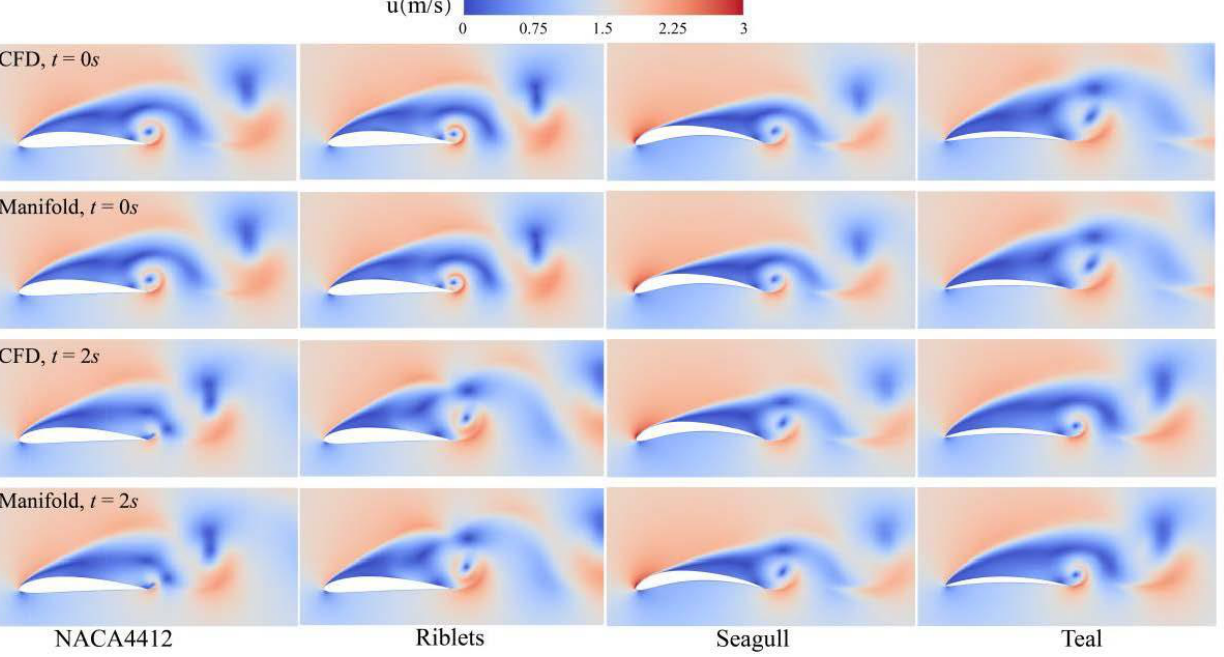
Figure 11. Airfoil velocity field reconstruction based on manifold dynamics.